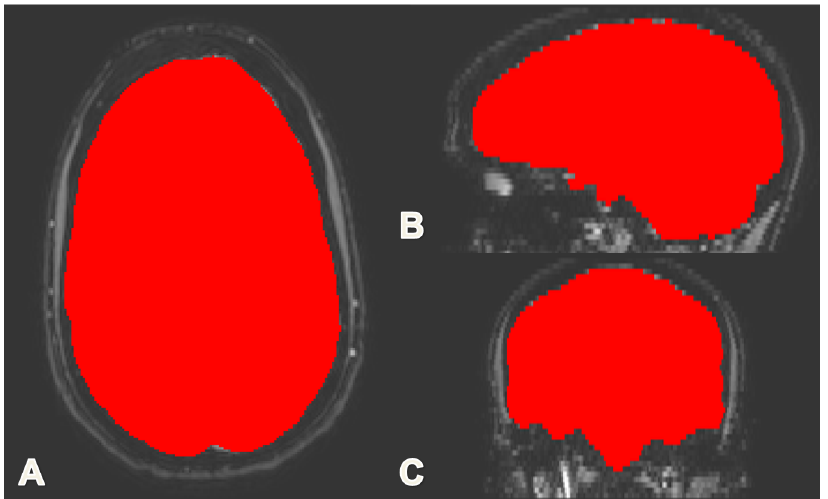
Fig 1. The CSF MRI sequence. After presaturation and T s the signal strength depends on T 1 decay to ensure an equal magnetization at the start of each MLEV-T 2 preparation. The MLEV-T 2 preparation with a varying amount of refocusing pulses allows the mapping of T 2 decay. Variation of time T s in combination with a fixed number of refocusing pulses allow the mapping of T 1 decay. A short T s is used to determine signal decay. Multi-slice echo planar imaging is used for the readout at each effective echo